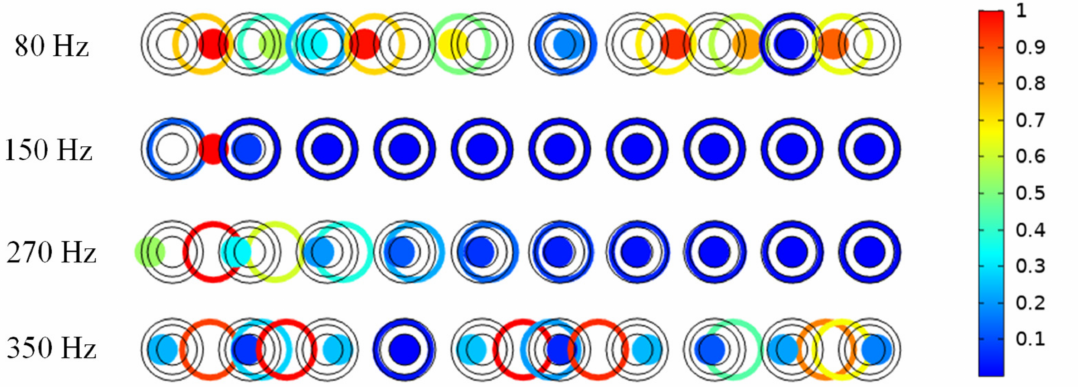
Figure 8. Displacement cloud